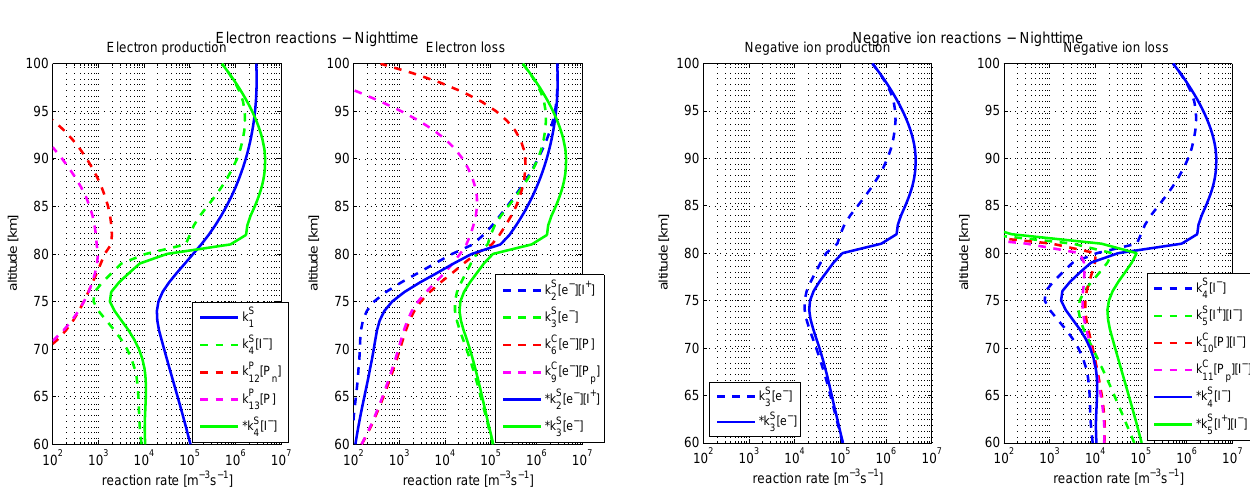
Fig. 11. As in Fig. 10, but for processes involving negative ions, see also Eq. (11).